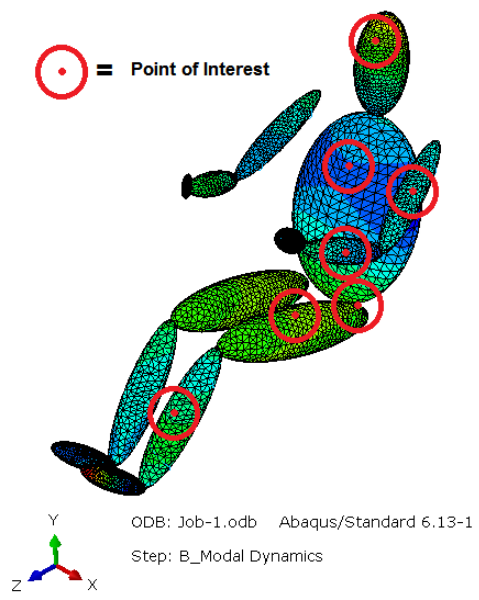
Figure 4. Points of interest and vertical acceleration.